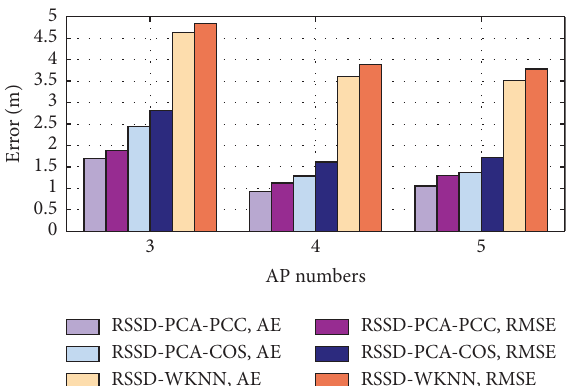
Figure 10: Error comparisons among RSSD-WKNN, RSSD-PCA-COS, and proposed RSSD-PCA-PCC with 3 APs, 4 APs, 5 APs, 2m grid distance, and K �